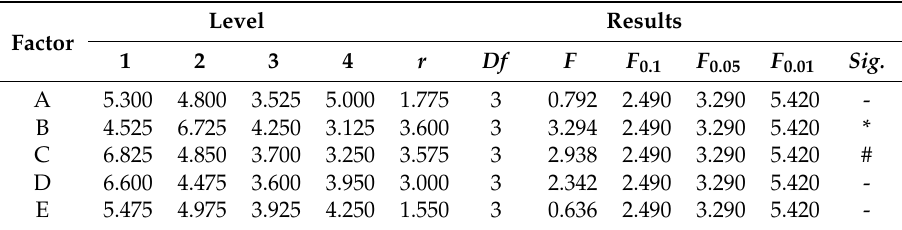
Table 6. Analysis of the factors influencing the compressive strength.